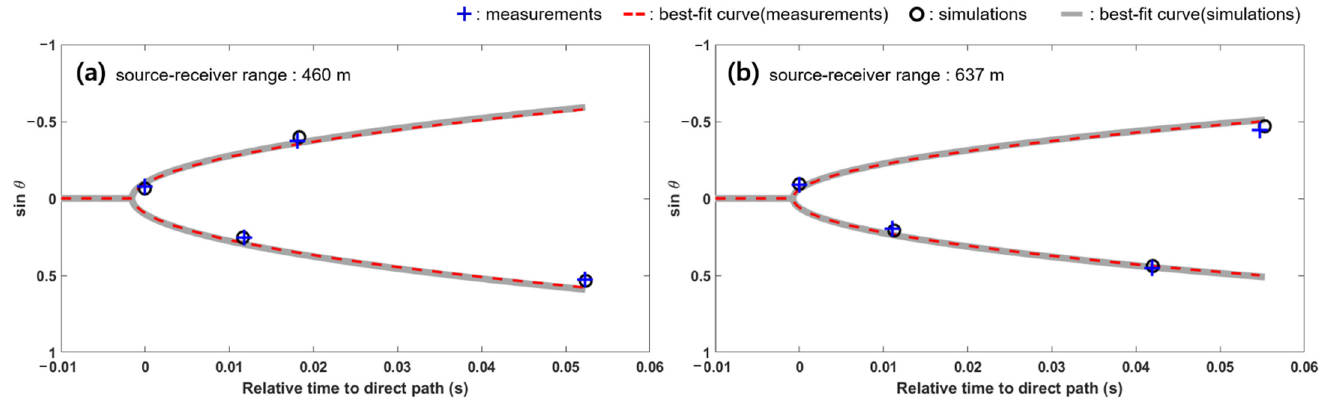
Figure 7. Estimated beam-time migrations and the best-fit elliptic curve solutions estimated using the measurement and simulation data for source–receiver ranges of ( a ) 460 m and ( b ) 637 m.